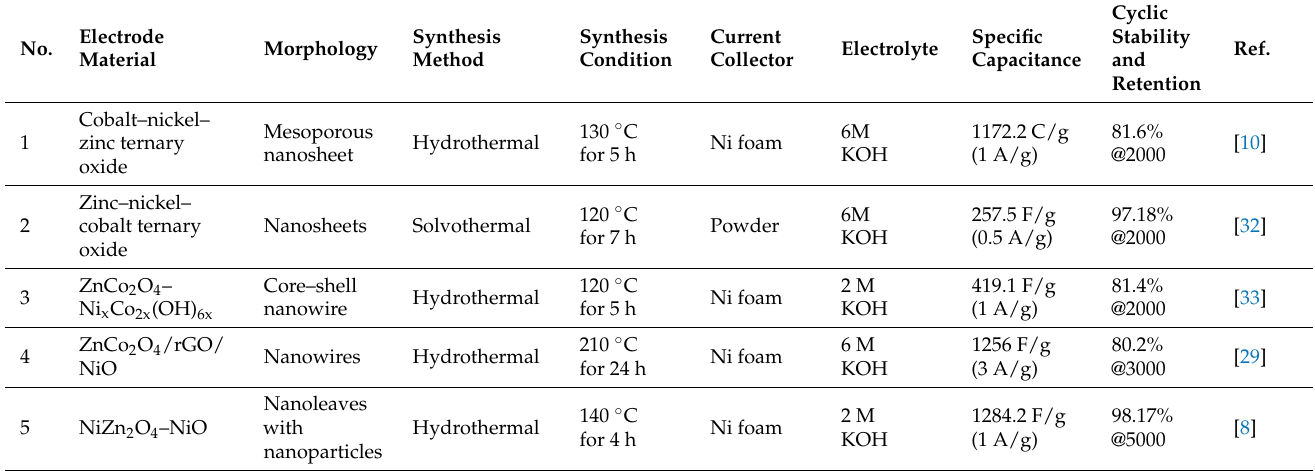
Table 1. Overall comparison between the electrode in this study and previously reported